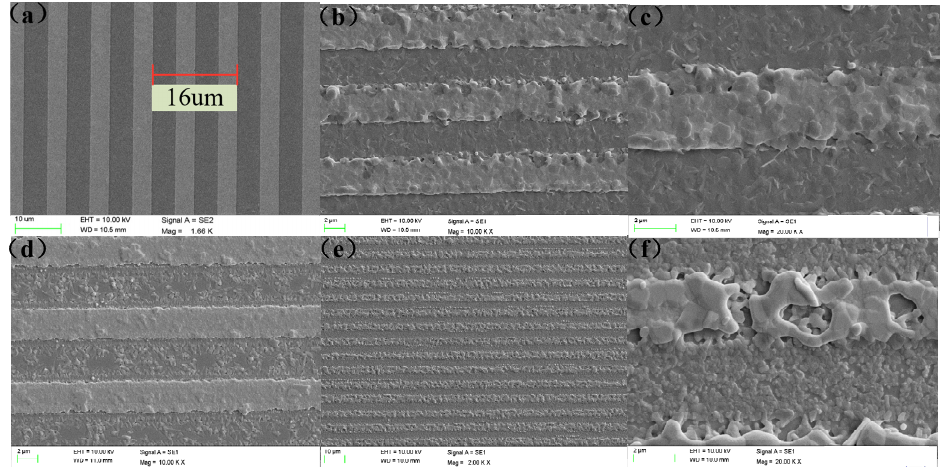
Figure 7. Surface topography of sensor samples: ( a ) before high temperature measurement; ( b ) grazing scanning electron microscopy (SEM) image of a AlN/Pt/Cr IDT after the first 1300 °C high temperature test; ( c ) partial enlarged view of IDTs; ( d ) grazing SEM image of AlN/Pt/Cr IDT after annealing at 1100 °C high temperature test; ( e ) grazing SEM image of AlN/Pt/Cr IDT after repeated annealing at 1300 °C high temperature test; and ( f ) partial enlarged view of IDTs.